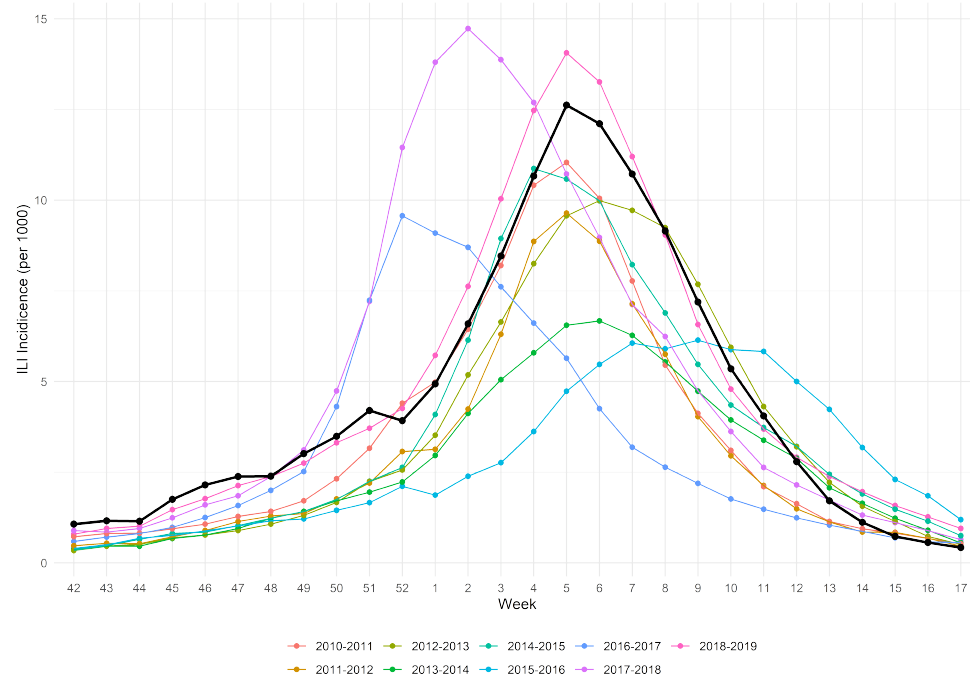
Figure 1. ILI incidence of 2019/2020 influenza epidemic (black line) along with 9 previous